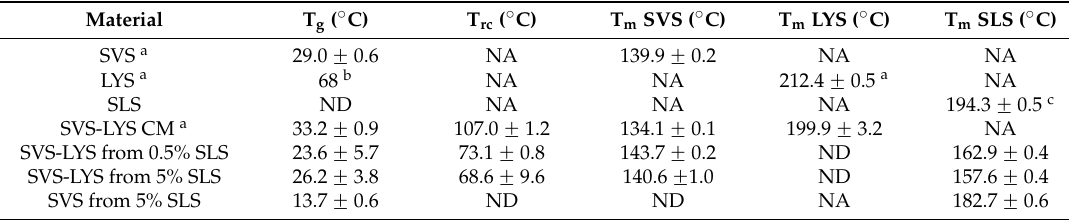
Table 3. Melting temperature (T m ), glass transition (T g ), and recrystallization temperature (T rc ) of the pure starting materials compared to the prepared samples.